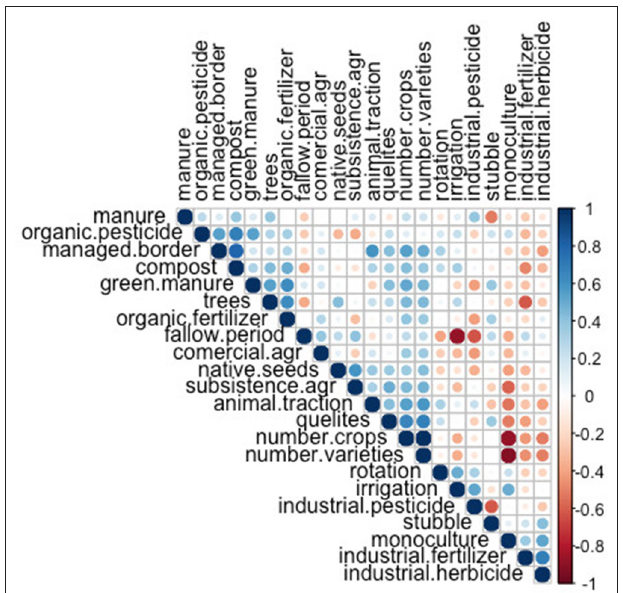
FIGURE 2 | Spearman correlation coefficients between management